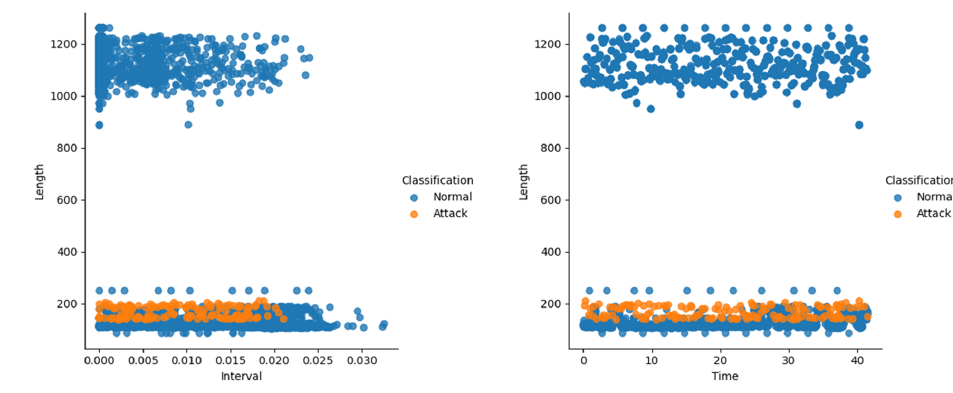
Figure 3. 2D scatter of Linear Interpolation based attack.